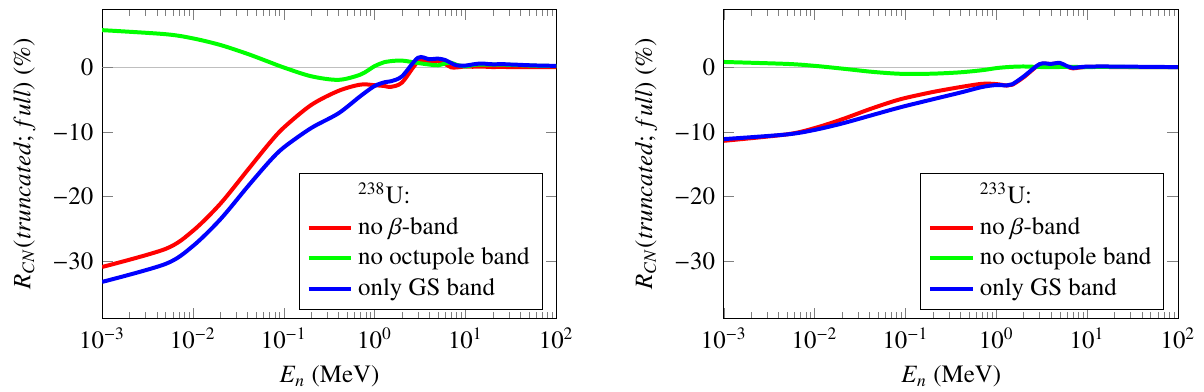
Figure 3. Direct level excitation cross sections within current model. Cross sections for levels from non-GS bands are summed over each band. Several GS band levels are shown for comparison. Left – 238 U, right – 233 U.